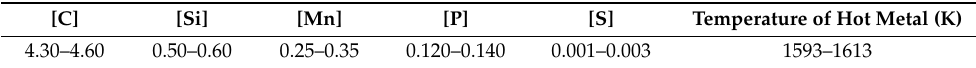
Table 1. Compositional content and temperature of the hot metal